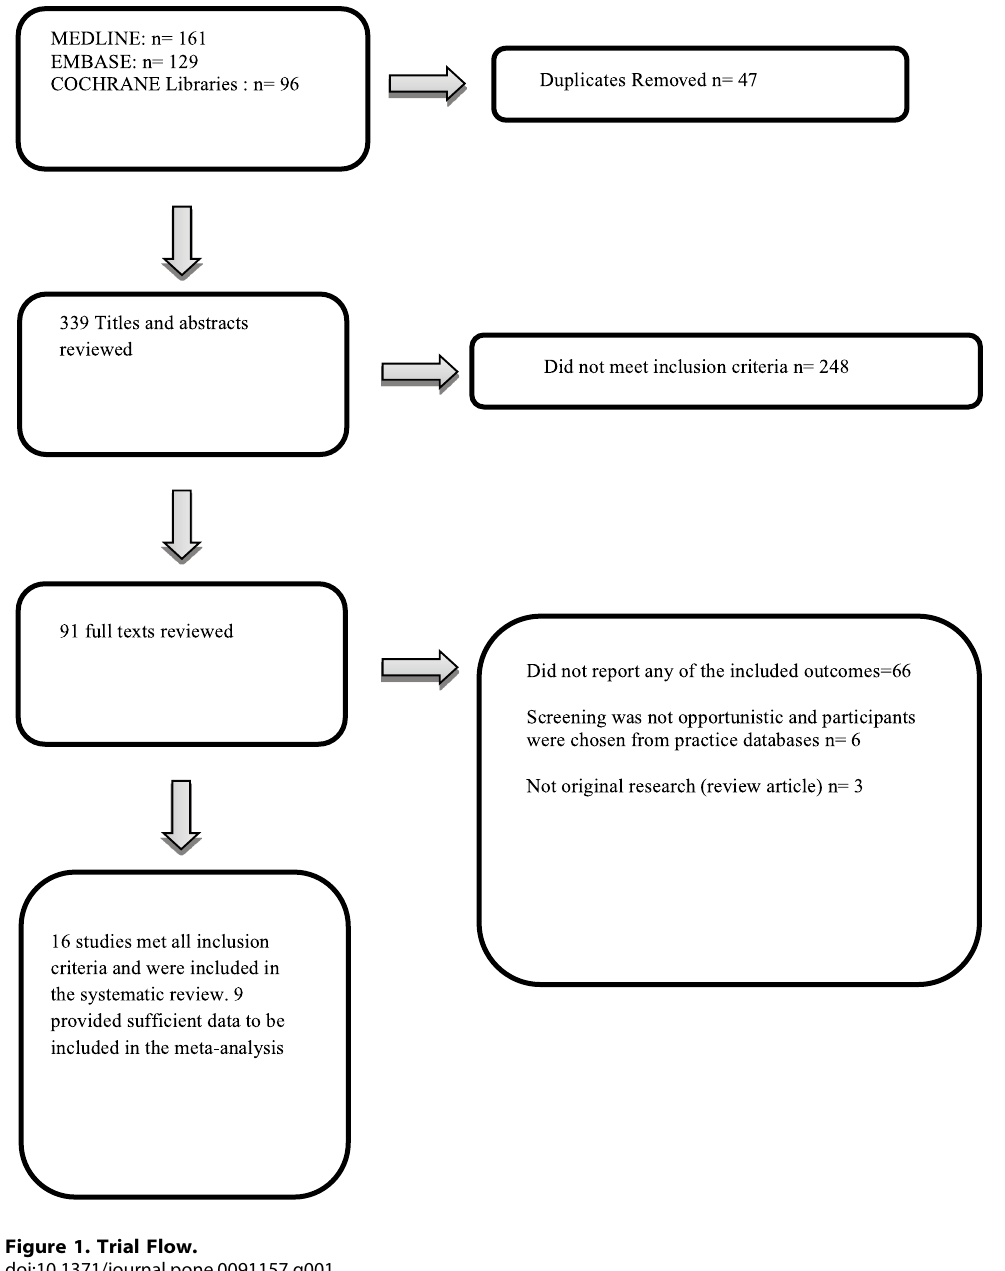
Figure 1. Trial Flow.